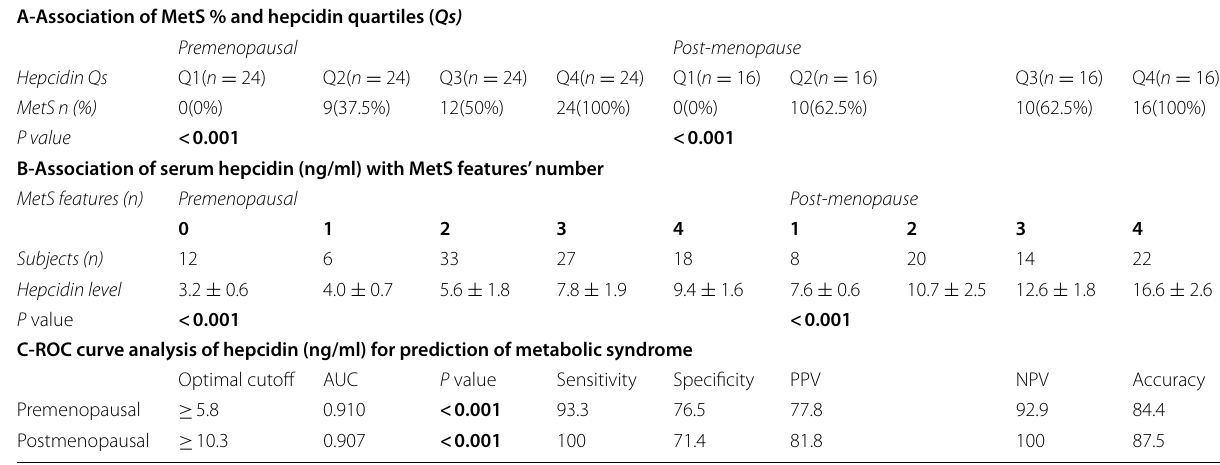
Bold: significant at p value < 0.05